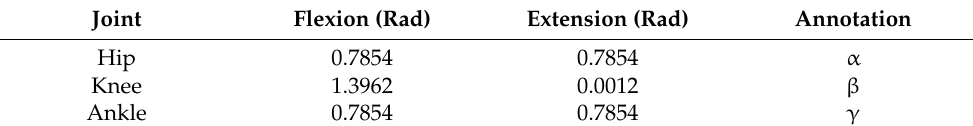
Table 2. Limiting rotation angle and annotation of joints.